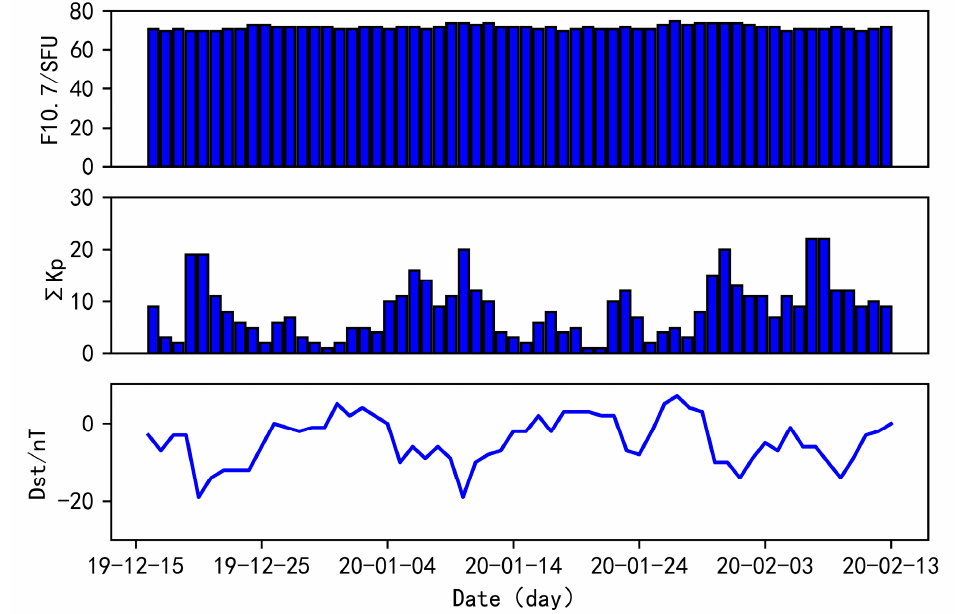
Figure 12. Change in the space weather index from 15 December 2019 to 13 February 2020.